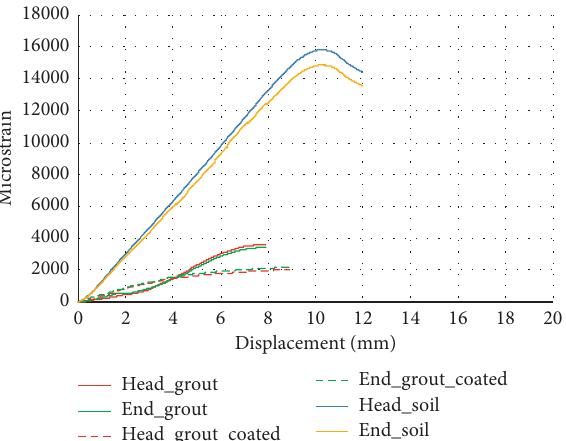
Figure 24: Strain vs. displacement at head and endpoints for uncoated GFRP rock bolt sensors fixed with grout and soil and coated GFRP rock bolt sensor fixed with grout.